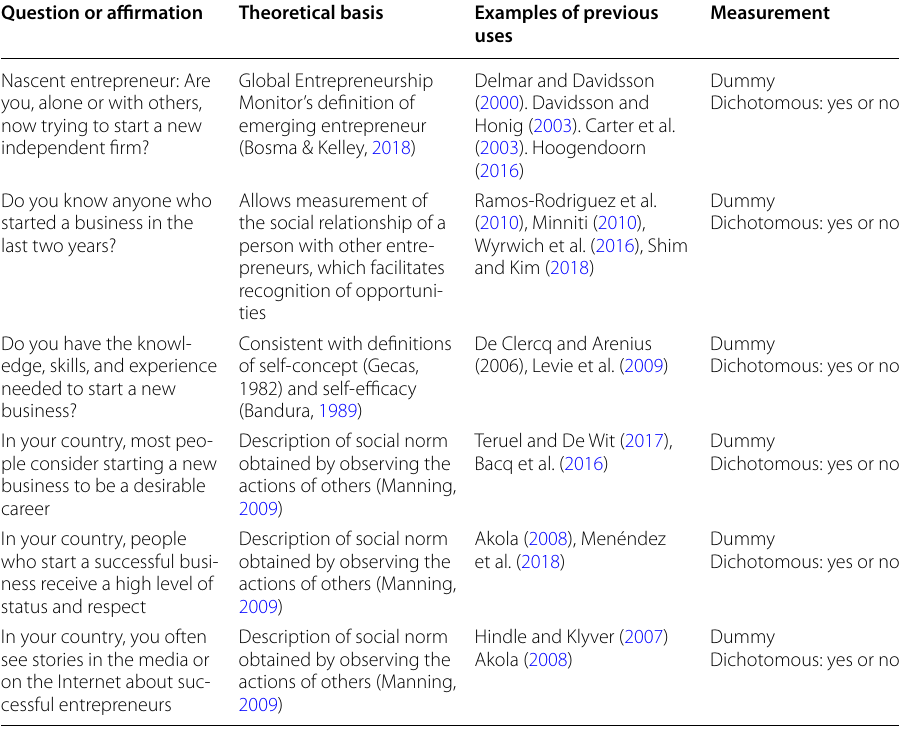
Table 1 Questions and affirmations used in the analysis Question or affirmation Theoretical basis Examples of previous uses